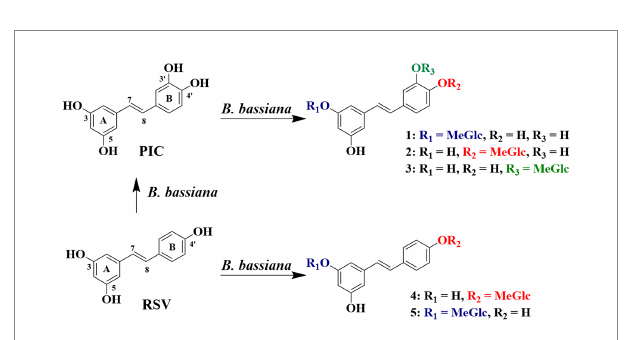
FIGURE 2 Conversion route of RSV and PIC by Beauveria